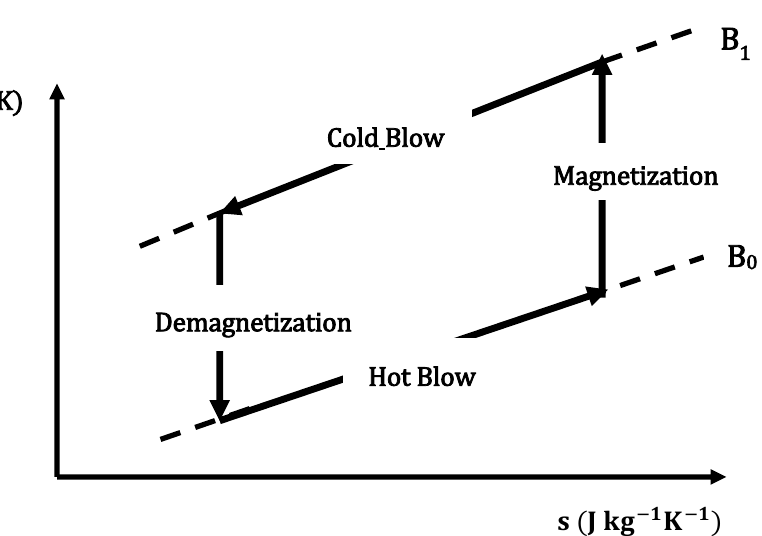
Figure 2. Schematic demonstrating temperature relative to entropy for the magnetic refrigeration cycle with the active regenerator.